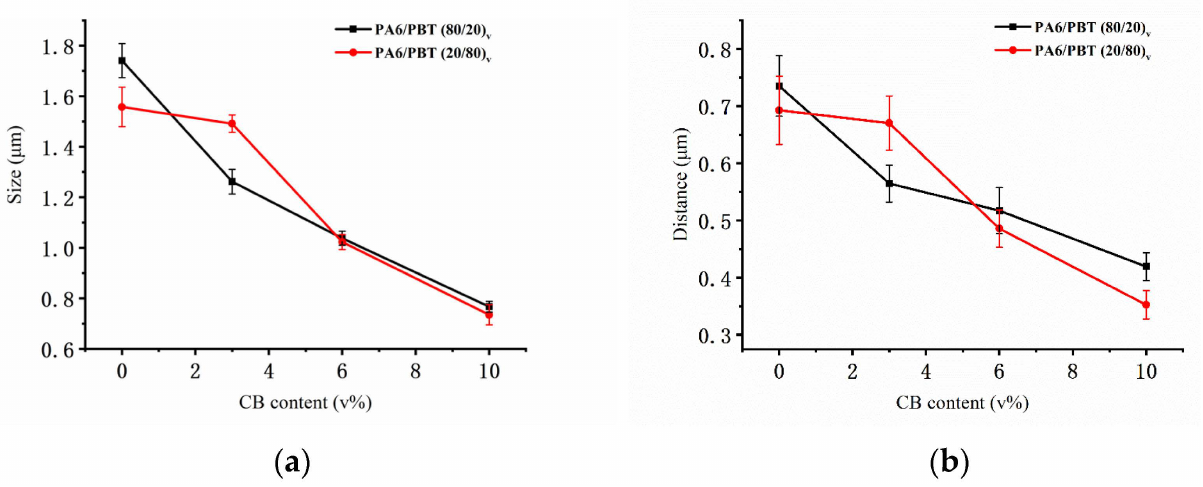
Figure 5. Average domain size ( a ) and average inter-domain distance ( b ) as a function of CB content in PA6/PBT(80/20)-CB and PA6/PBT(20/80)-CB